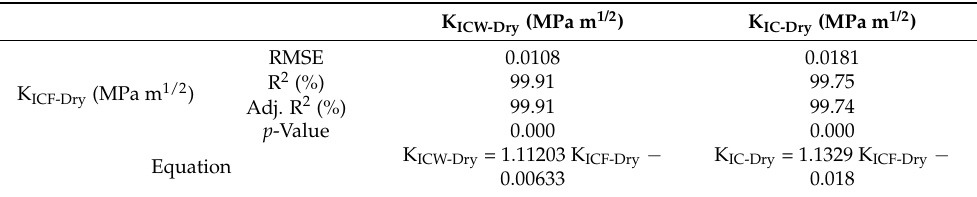
Table 4. Correlation among K IC determined from three different methods under a dry condition.